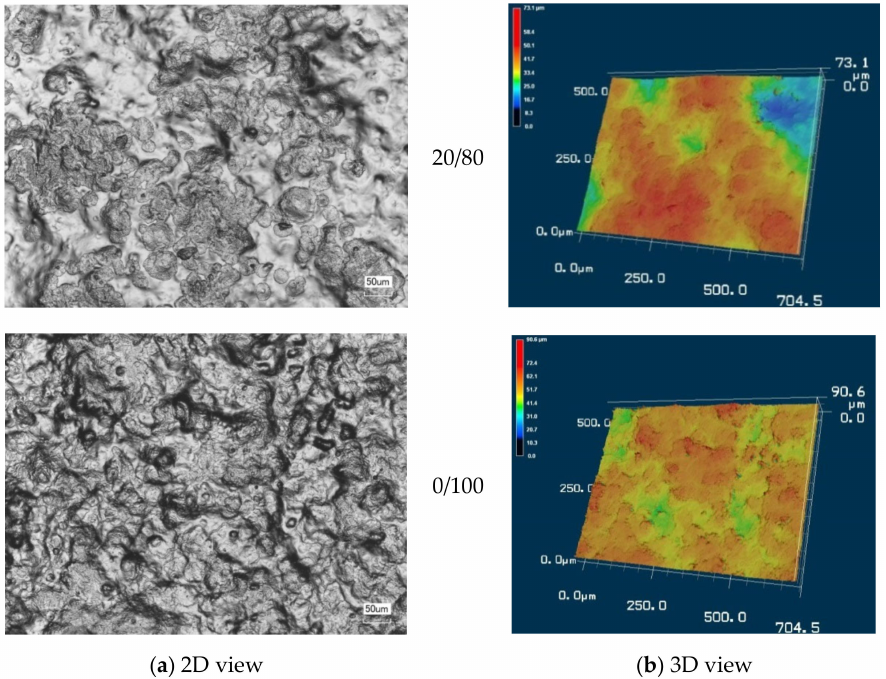
Figure 5. Laser scanning microscopy: ( a ) topographical images and ( b ) 3D images of CMS / CMC- based films.